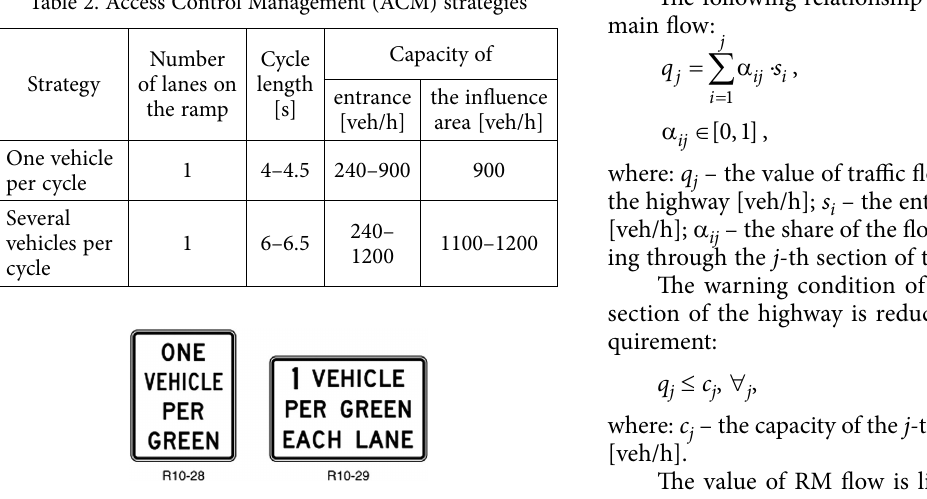
Fig. 4. Access control signs in the USA